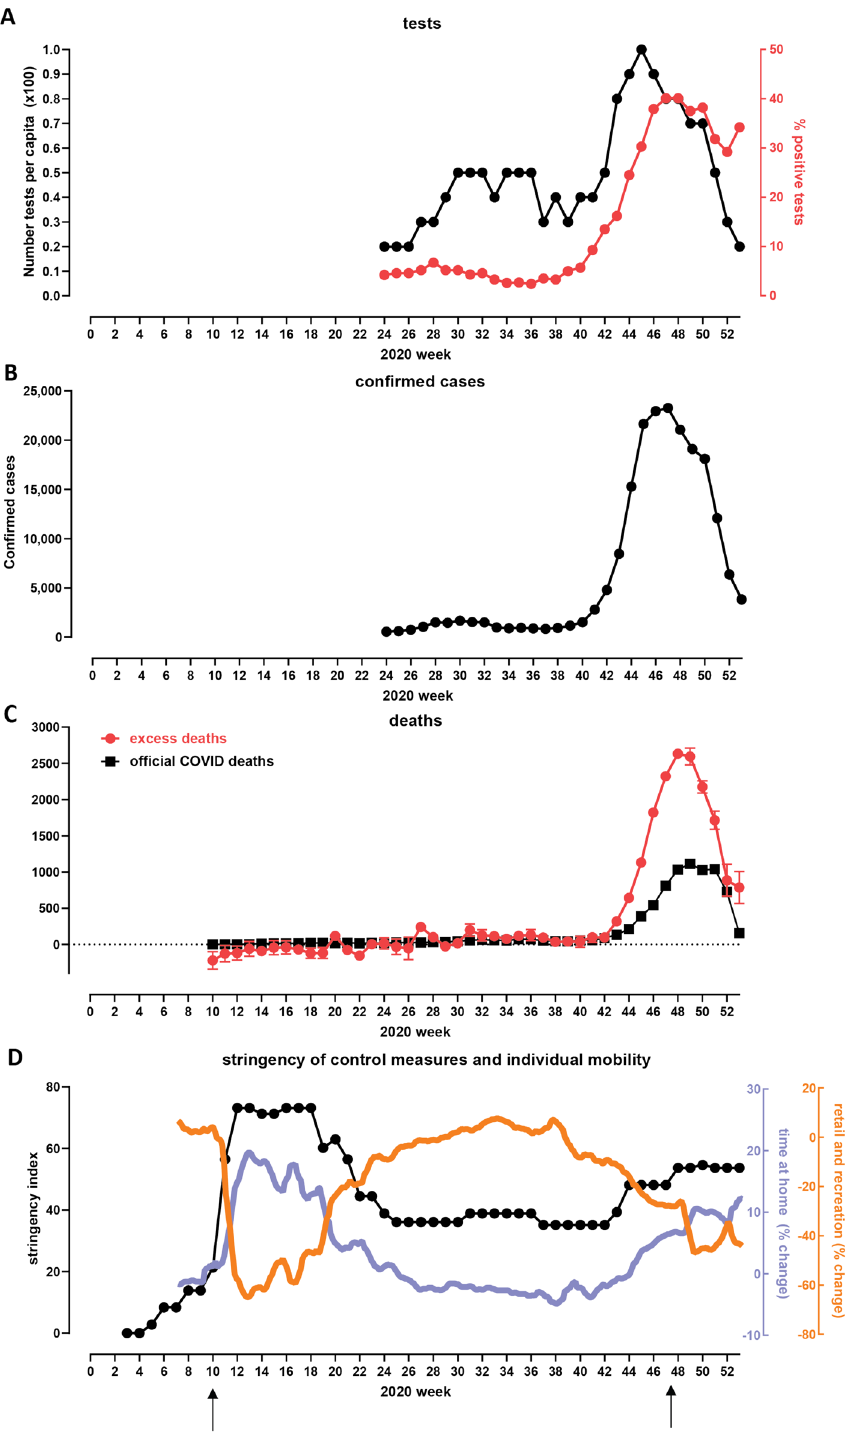
Figure 7. Development of the COVID pandemic in Bulgaria over 2020 and the effectives of measures implemented in order to control it. ( A ) Number of tests conduced and test positivity percentage over the second half of 2020. a Official daily testing data was only made available from 06 Jun 2020–Open Data Portal (https:// data. egov. bg/ data/ resou rceVi ew/ e59f9 5dd- afde- 43af- 83c8- ea291 6badd 19). ( B ) Officially registered COVID cases. Note that rapid antigen tests were only included in statistics starting from December 22nd 2020. ( C ) Officially registered weekly COVID deaths and overall weekly excess mortality over the course of 2020. ( D ) Social mobility changes and the timing of imposition of restrictions. Arrows indicate the time of imposition of “lockdown” measures. “Time Home” refers to the change of the number of visitors to residential areas relative to the period before the pandemic. “Time Retail and Recreation” refers to the change of the number of visitors to places of retail and recreation relative to the period before the pandemic. This includes restaurants, cafes, shopping centers, theme parks, museums, movie theatres,